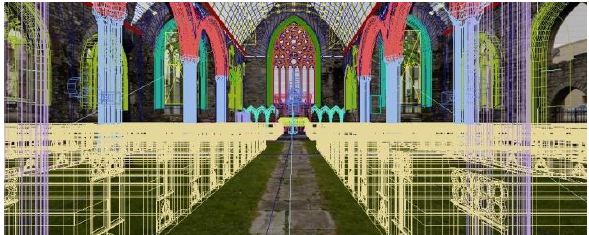
Figure 9 3D model overlaid with panoramic